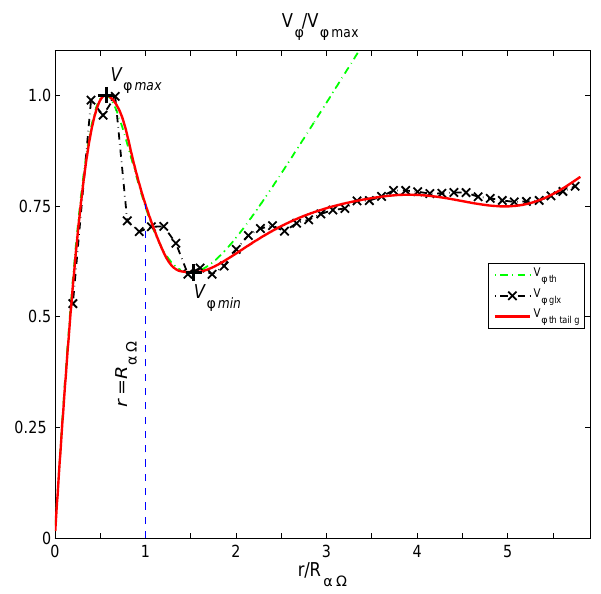
Figure 2. Rotation curves in normalized units: the same as in the Figure 1 for the M31 – crosses and dashed lines; the model rotation curve (7), (8), used in this work – thick solid red line; the profile (6) used in the previous work (TO) – green dotted line; normalization parameters: V = 340 km / s , R = 2.85 kpc ; other parameters φ max α Ω – see